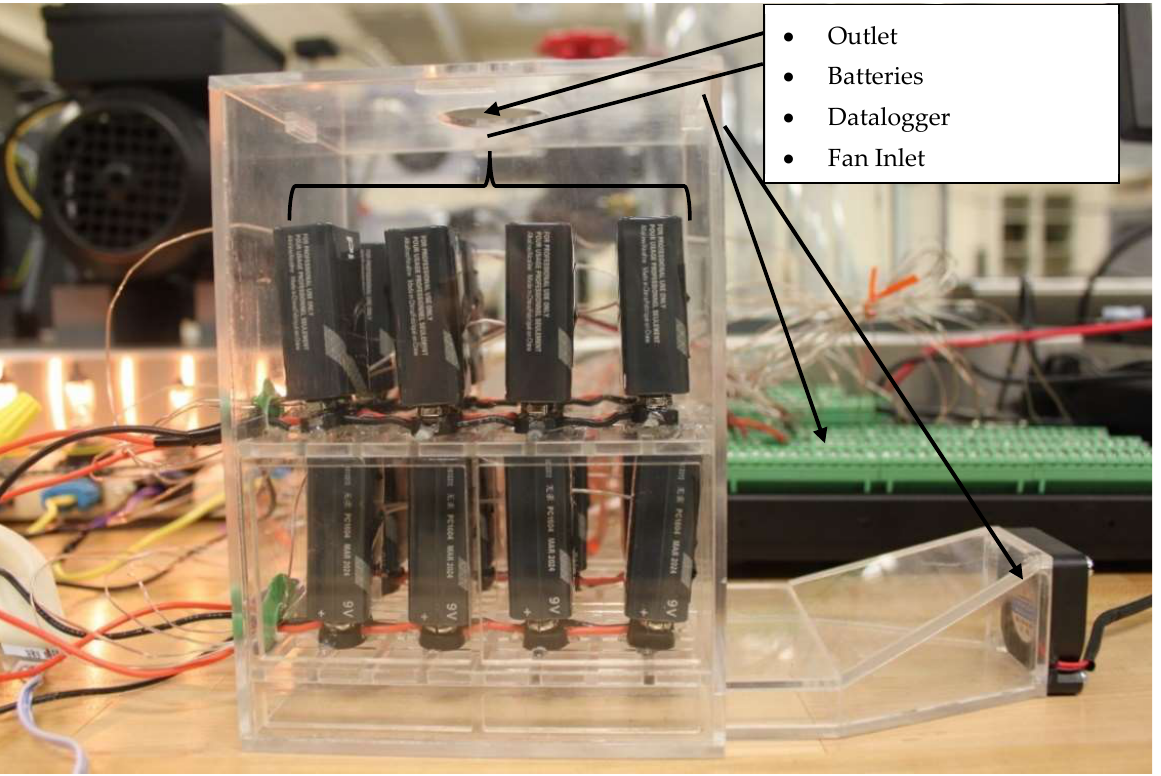
Figure 6. Data collection trial for the default model. Wires exiting through the backside of the case can be seen. Holes for wires/thermocouples were sealed with putty.